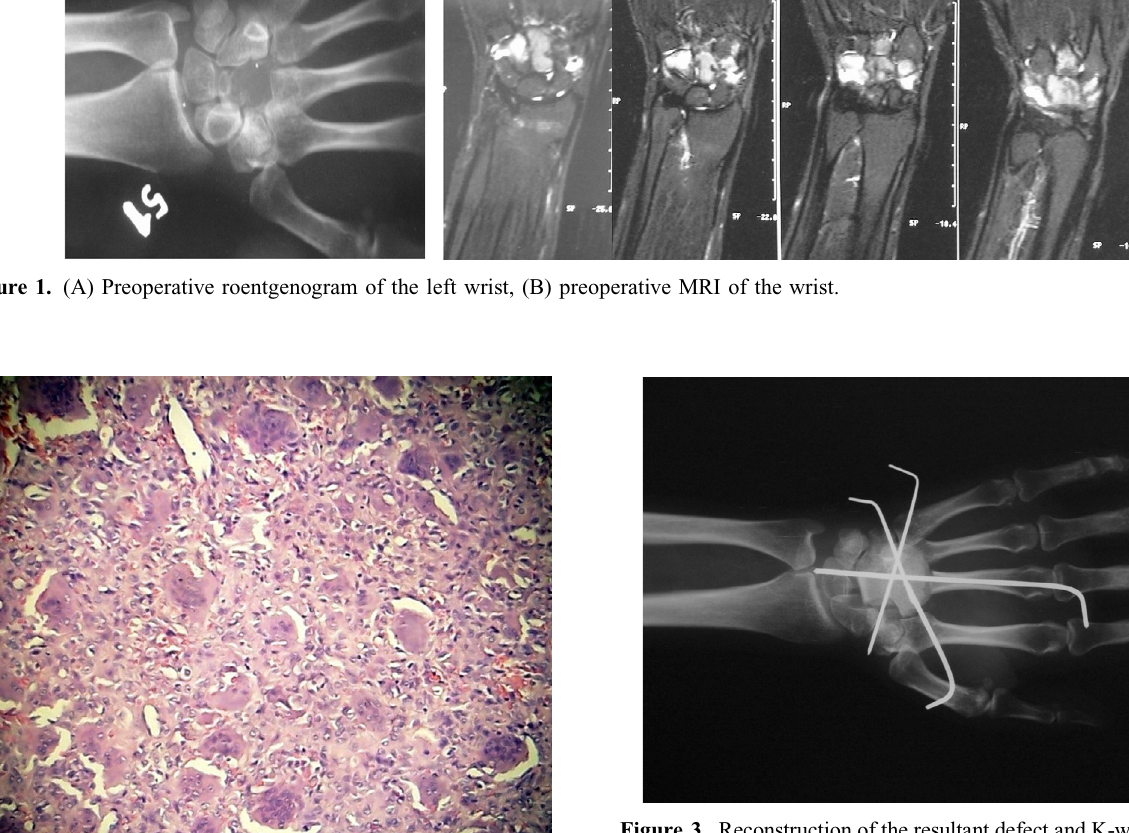
Figure 3. Reconstruction of the resultant defect and K-wire fixation.